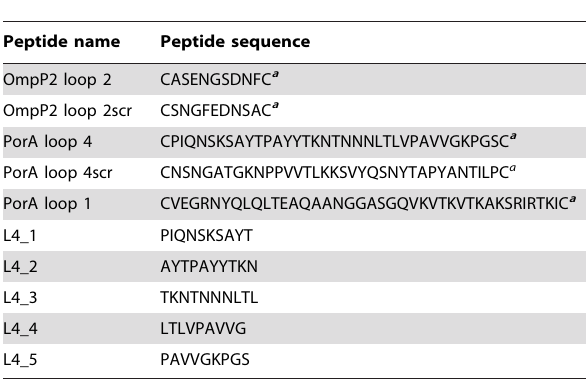
Table 1. Synthetic peptides used in this